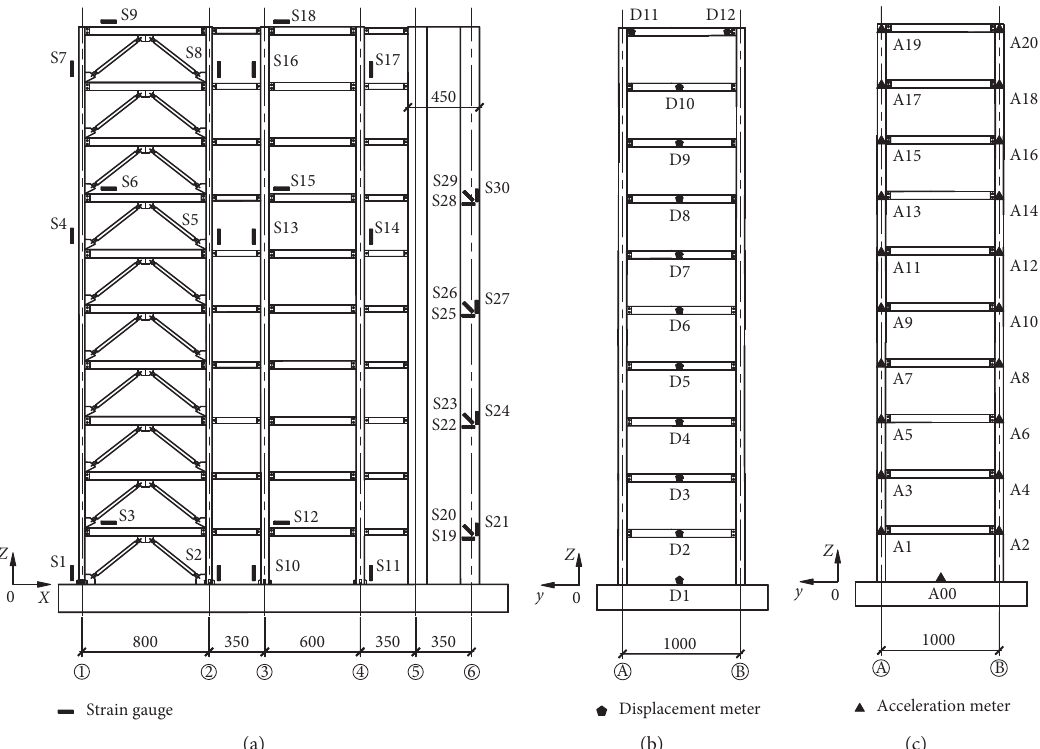
Figure 11: Measurement scheme. (a) Strain meters and rosettes. (b) Displacement meters. (c) Acceleration meters.